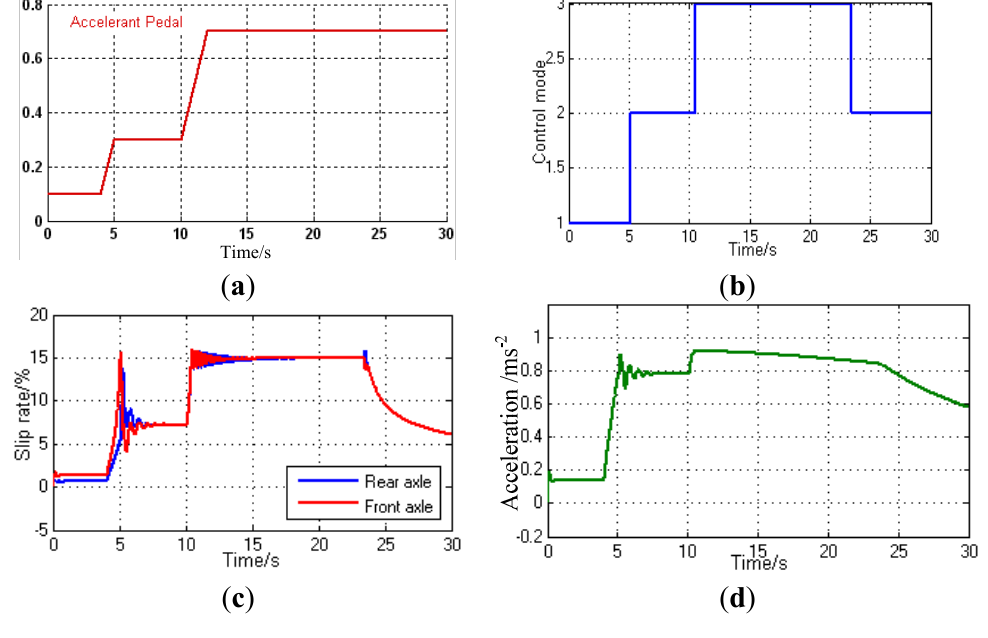
Figure 12. Simulation results under the same road with the changing driver accelerator pedal: ( a ) Driver accelerator pedal signal; ( b ) The change of control mode under inter-axle torque distribution control strategy; ( c ) Change of slip rate; ( d ) Vehicle